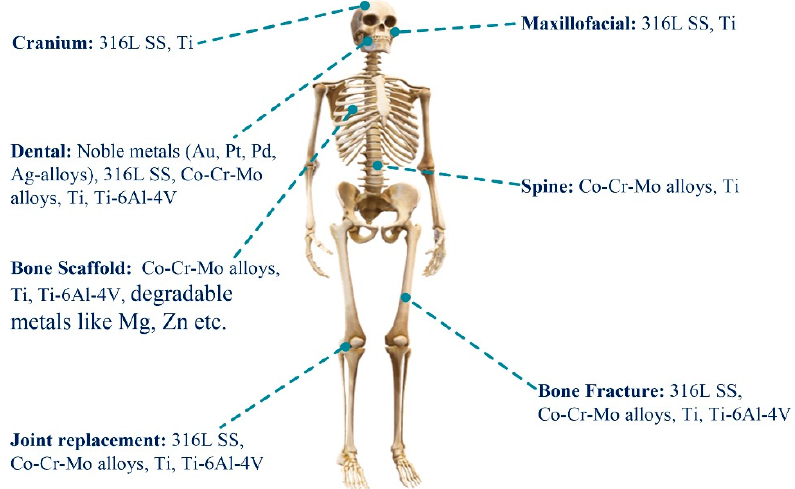
Figure 4. The clinical application of common metal implants.